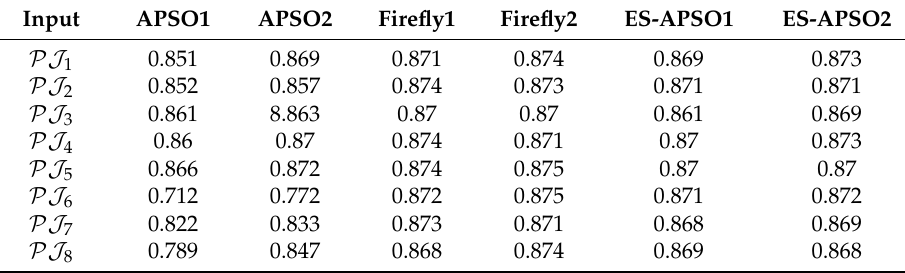
Table 2. The mean values of MIR